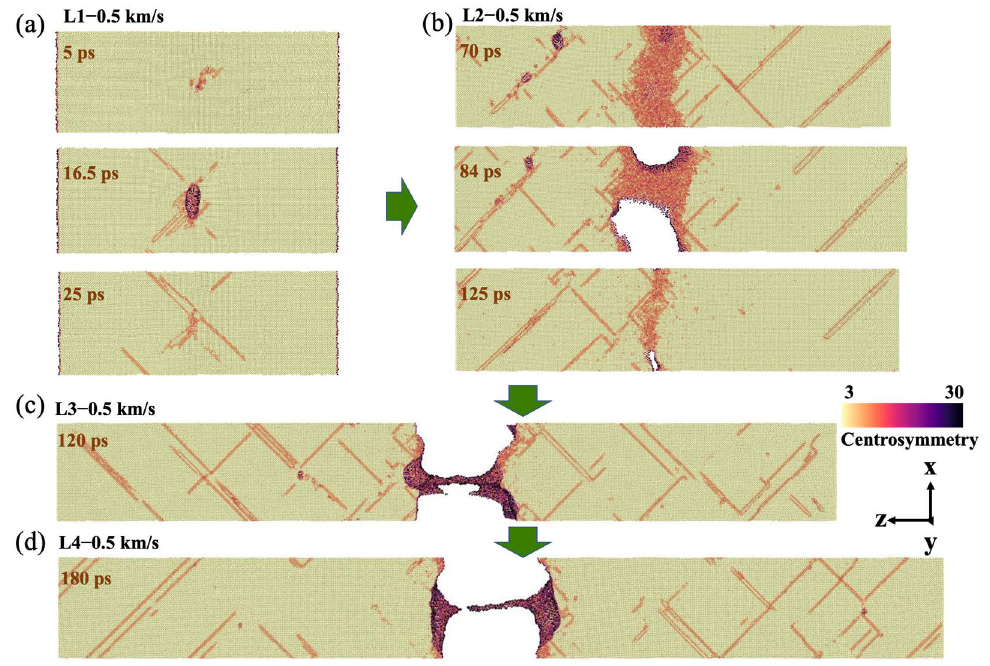
Figure 6. Microscopic views of void evolution of ( a ) L1, ( b ) L2, ( c ) L3, and ( d ) L4 at specific times (microscopic views were sliced from the center axis) at v 0 = 0.5 km/s.